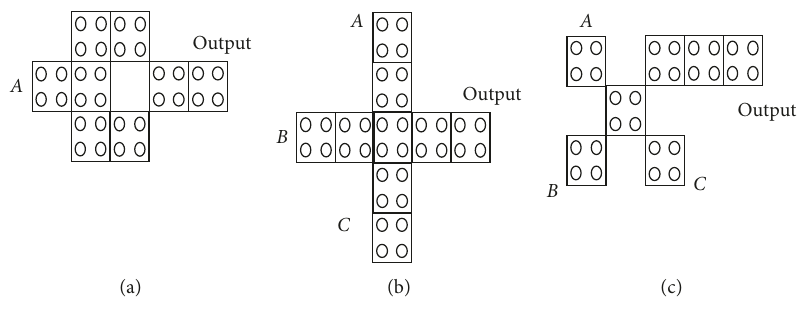
Figure 4: Inverter gate (a) and majority gate (b, c).